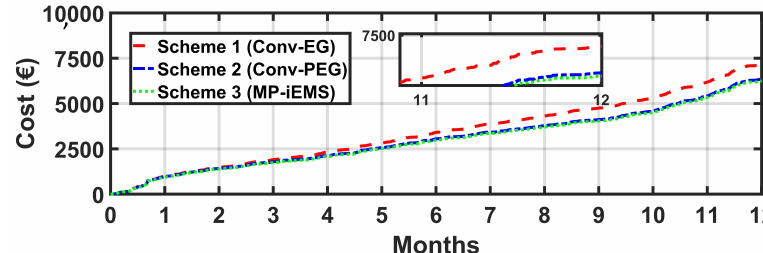
Figure 15. Total grid energy